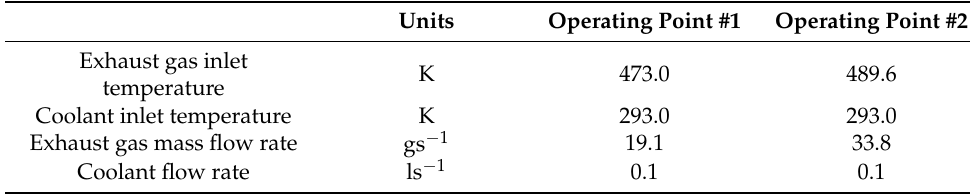
Table 2. Model boundary conditions for the two operating points analyzed.